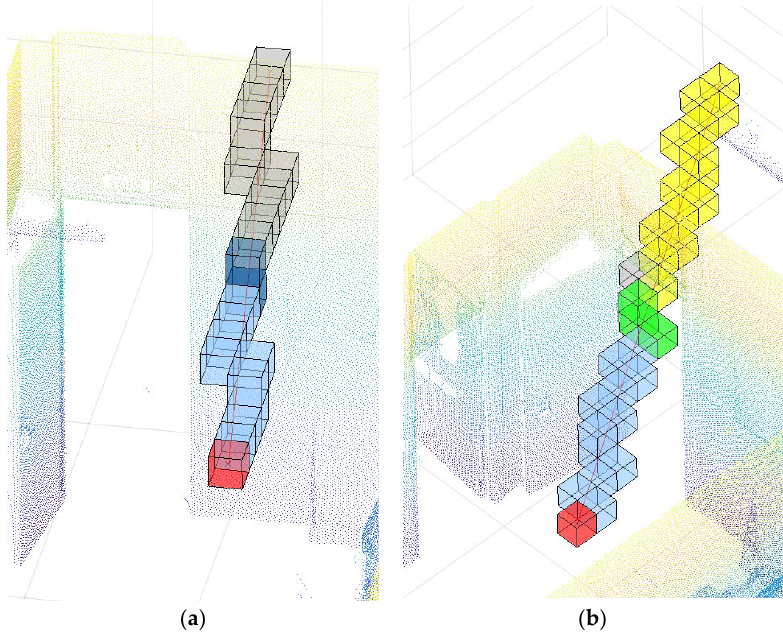
Figure 12. Ray-tracing study: ( a ) occluded voxel; ( b ) non-occluded voxel. Red: scanner position; dark blue: occupied voxel; light blue: empty voxel; grey: occluded voxel; green: door voxel; yellow: out voxel.